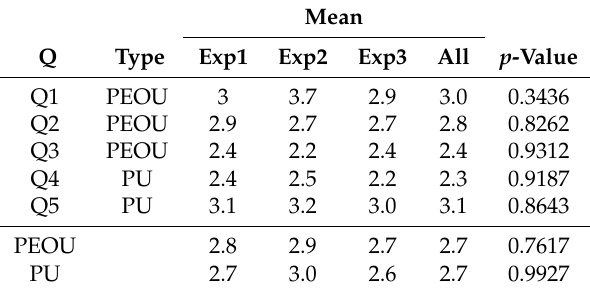
Table 5. Questionnaire Analysis Results—Descriptive